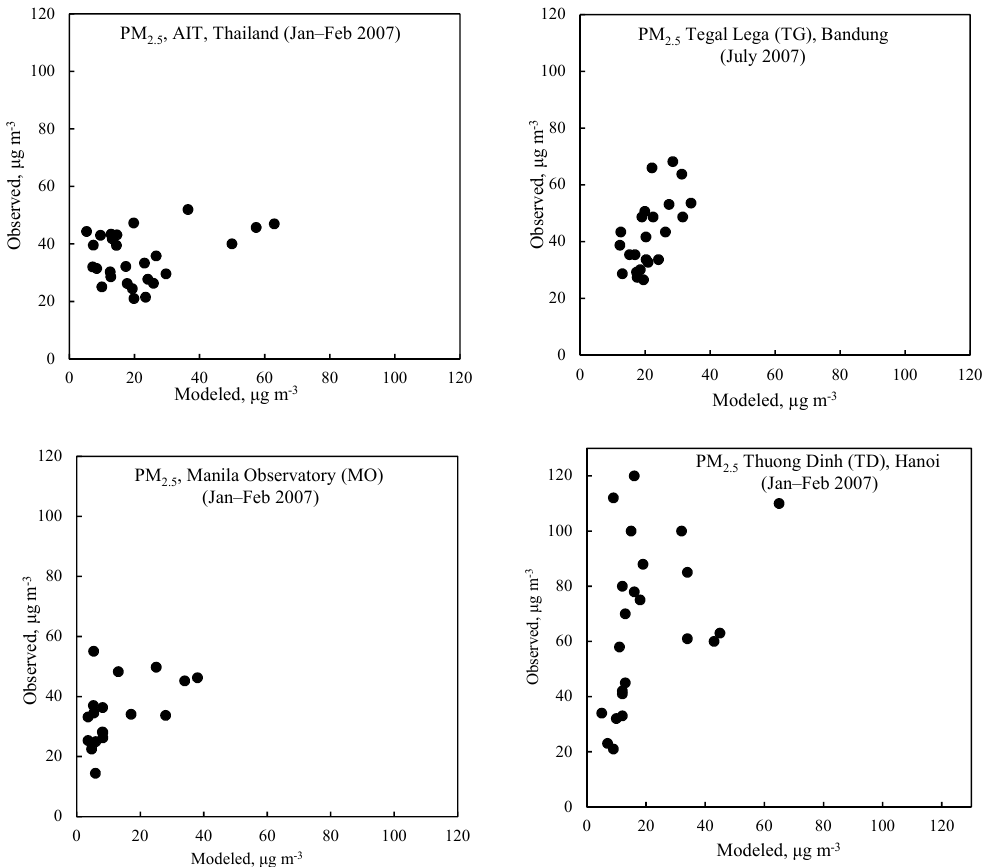
Figure 4. Scatter plots of modeled vs. observed 24hPM 2 . 5 at four AIRPET sites, 2007.